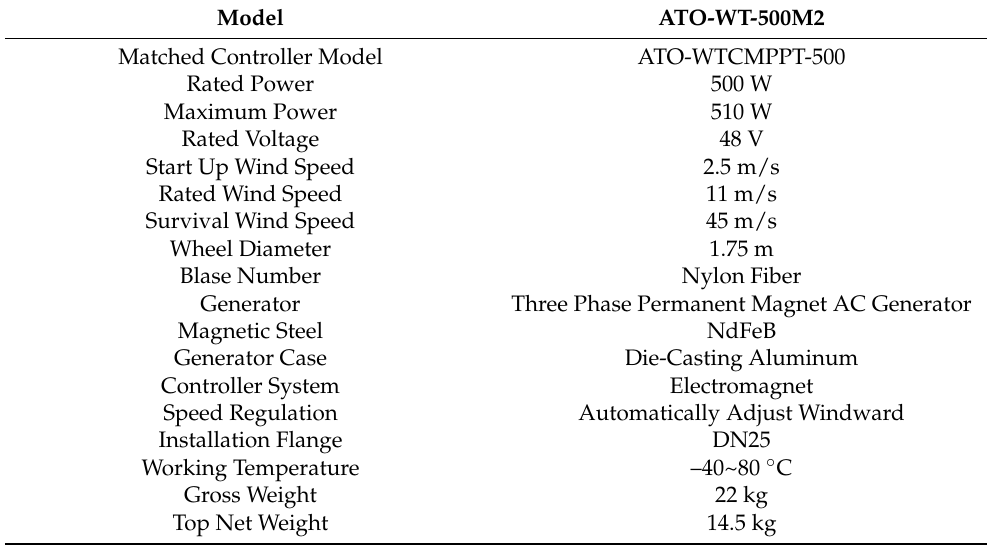
Table 5. Characteristics of the selected wind turbine model. Model ATO-WT-500M2 Matched Controller